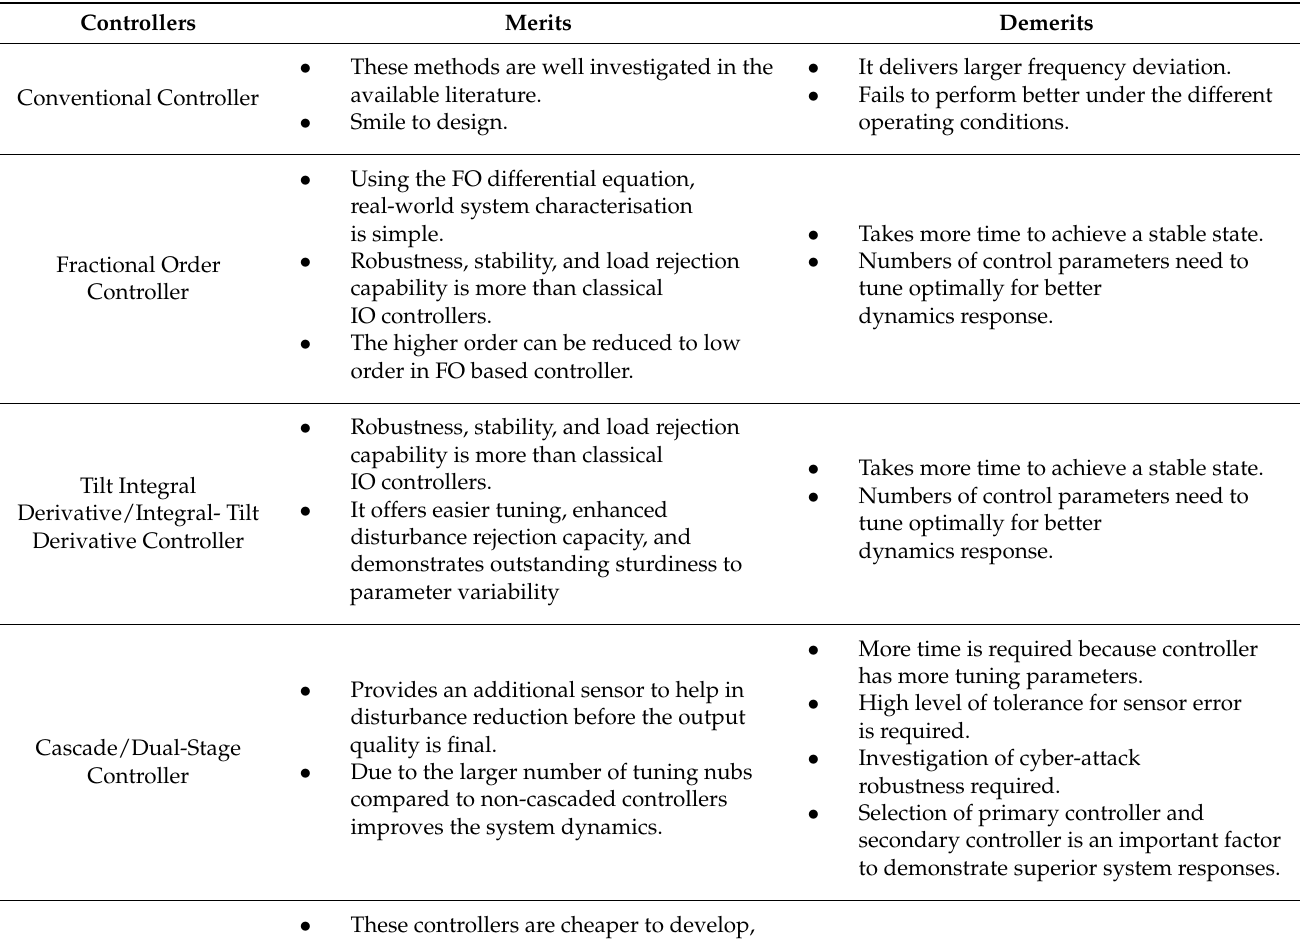
Table 4. Merits and demerits of